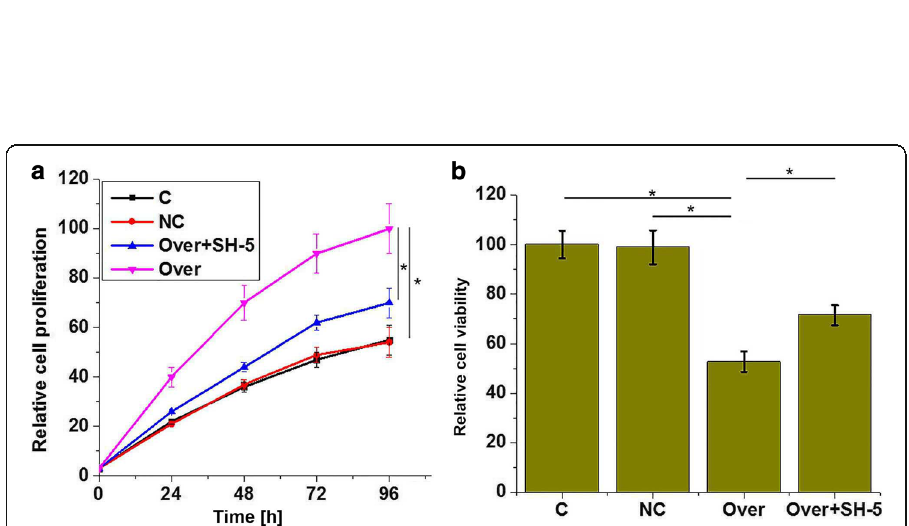
Fig. 4 The effects of lncRNA-ATB overexpression on the proliferation and viability of chondrocytes. a Cell proliferation under different conditions. b Cell viability under different conditions. * p < 0.05. C, control; NC, negative control; Over, lncRNA-ATB overexpression. The proliferation and viability of chondrocytes after lncRNA-ATB overexpression were respectively analyzed using the CCK-8 and MTT assays. LncRNA-ATB overexpression promoted the proliferation and increased the viability of